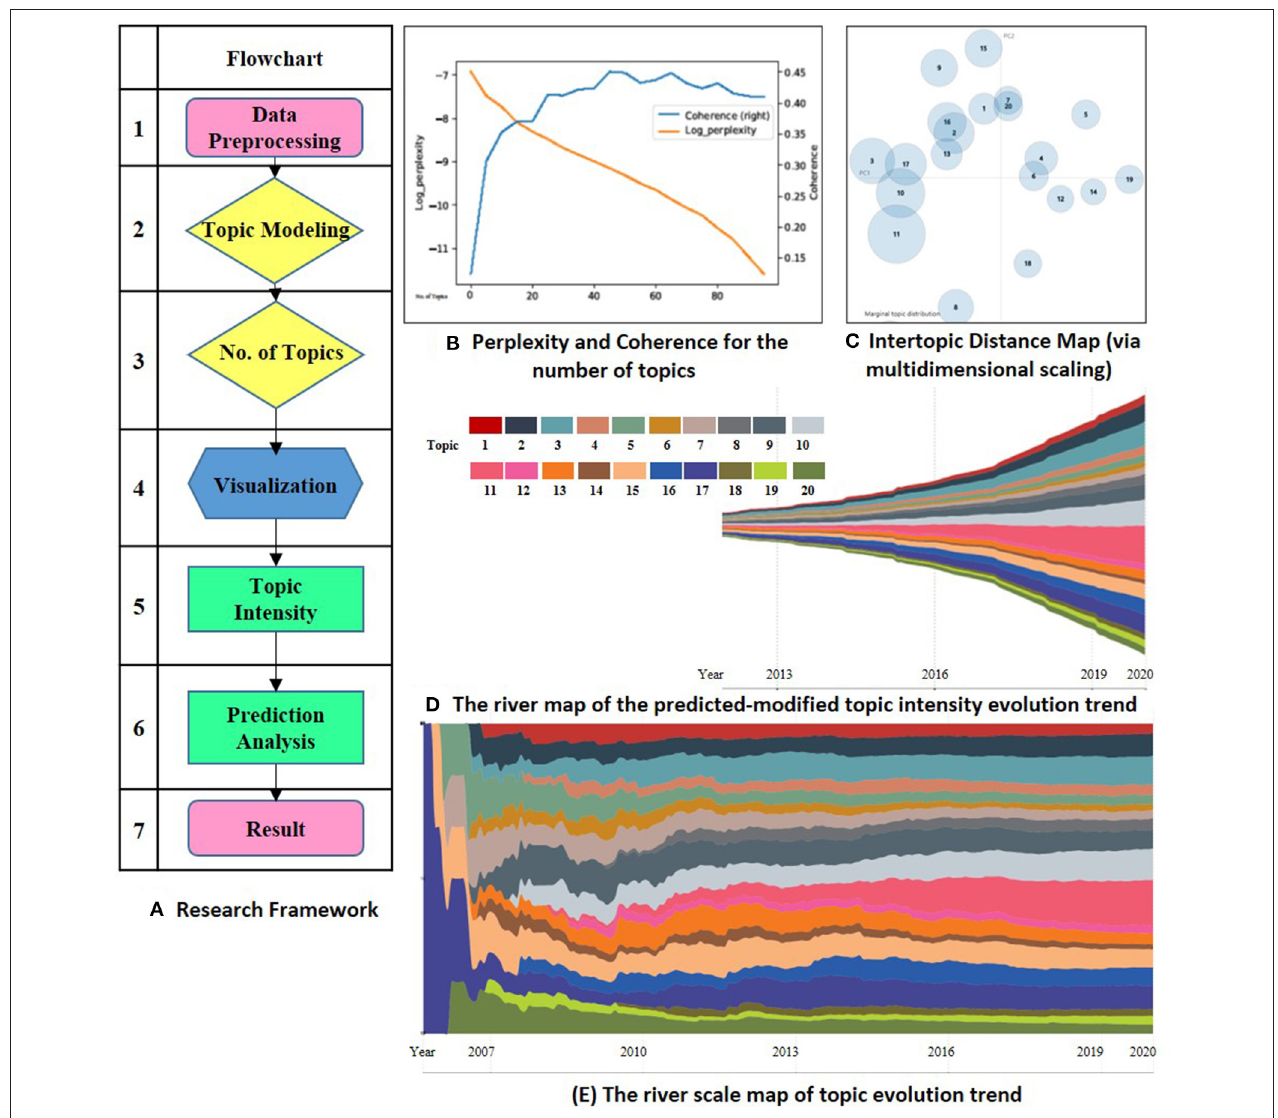
FIGURE 1 | (A) is the research framework. (B) shows the perplexity and coherence for the number of topics. (C) visualizes the lntertopic distance for the 20 topics. (D,E) is the river map and river scale map of the predicted-modified evolution. Topic 1 biomarker discovery in early diagnostics, 2 machine learning for cancer prediction, 3 novel biomarker identify technology, 4 multi-omics in Hepatocellular Carcinoma, 5 genomics in clinical application, 6 genomics in tumor heterogeneity discovery, 7 proteomics in post-translational modification, 8 transcriptional and metabolic processes, 9 metabolomics of breast cancer, 10 genomics of colorectal cancer, 11 multi-omics analysis, 12 cancer vaccines, 13 tumor immunotherapy, 14 metabolomics in prostate cancer, 15 pharmacogenomics, 16 genome-guided therapy regimens, 17 non-coding RNA target genes, 18 microbial metabolomics, 19 metagenomics, 20 genomics of colorectal